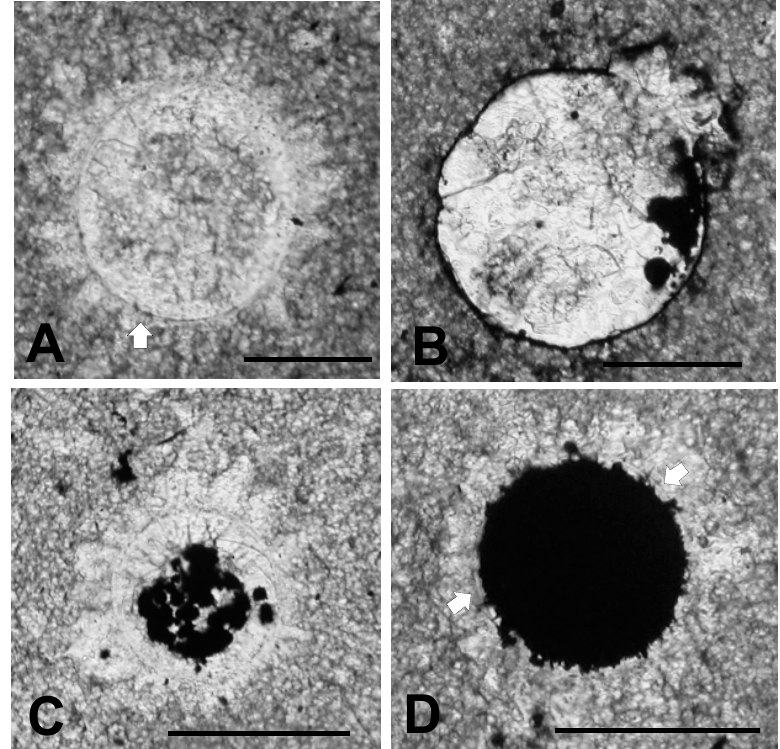
Figure 6. Microalgae in thin section showing progressive degrees of pyritization. All scale bars = 100 µm. ( A ) specimen (TYT-11) with crystalline calcite halos, as in Figure 4. Micrite fills most of the interior. Body wall is pyritized near white arrow; ( B ) specimen (TYT-04) with pyritized wall and small masses of pyrite in the central body; ( C ) specimen (TYT-09) with numerous small masses nearly filling the central body; ( D ) (TYT-01) specimen nearly totally composed of pyrite but retaining a surrounding halo of calcite crystals. Original, body wall is visible near white arrows.